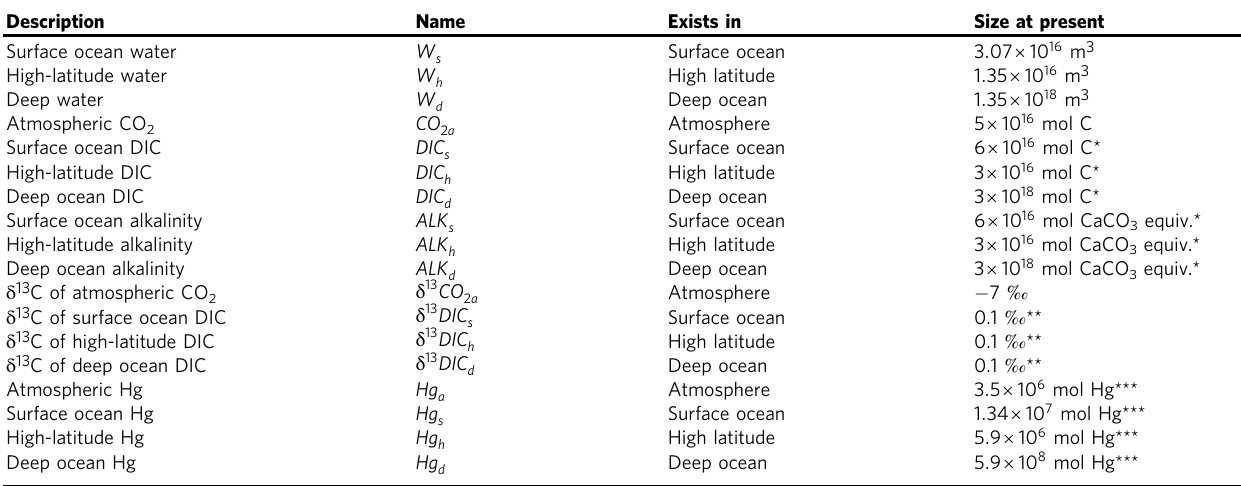
Table 1 Model species.